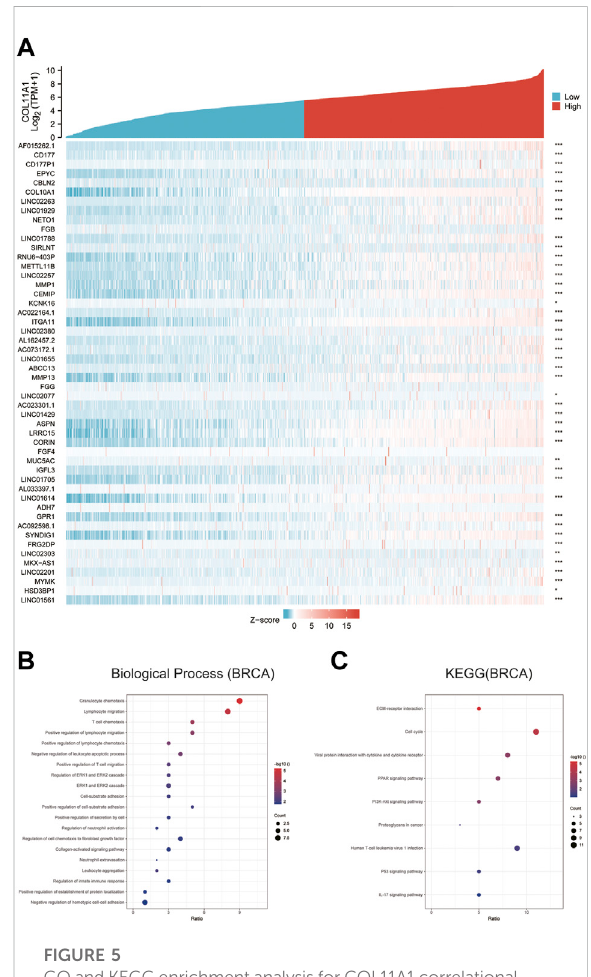
FIGURE 5 GO and KEGG enrichment analysis for COL11A1 correlational genes from TCGA database. (A) Heat maps showing the top 50 genes positively correlated with COL11A1 in BRCA. (B)